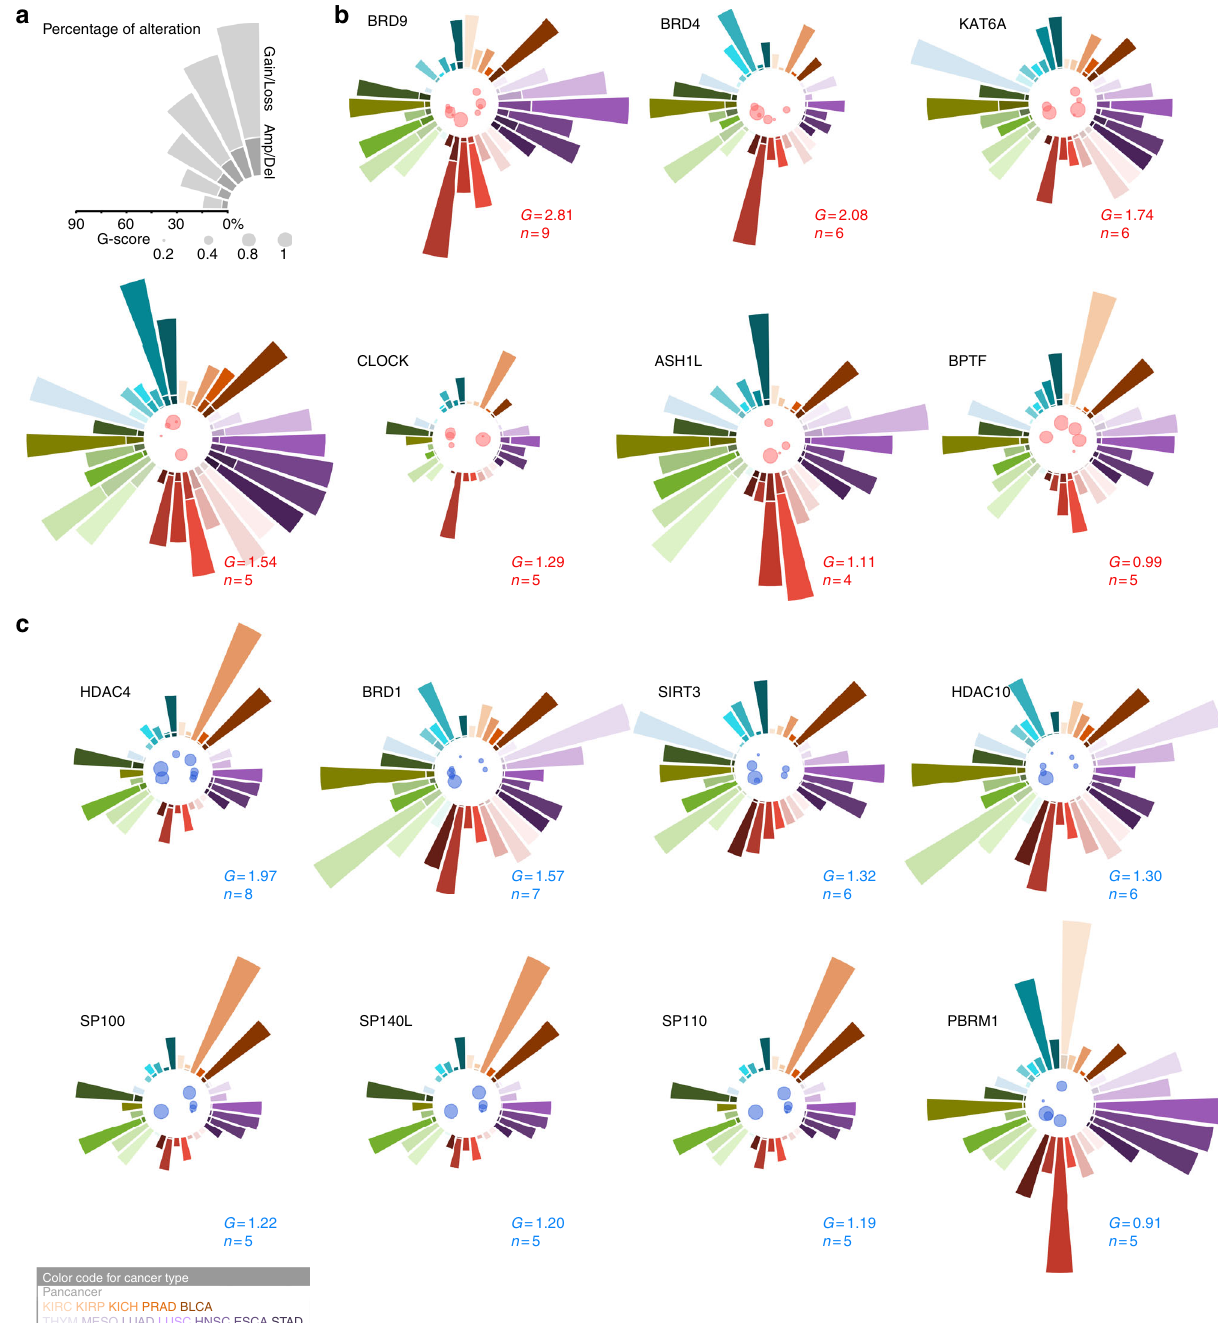
Fig. 3 The putative cancer-causing HAMPs driven by SCNAs across cancers. a The scales of the alteration percentage (upper) and G-score (lower). b , c Seven and eight putative cancer-causing HAMPs that are commonly and recurrently gained ( b ) or lost ( c ), respectively, across 33 cancers (overall G-score > 0.9). In the center of each circle, the cancer types that harbored recurrent alterations of a given HAMP are indicated by a color-coded bubble (red: gain; blue: loss). The size of the bubble plot represents the G-score of the HAMP in a given cancer type. The bar diagram of each circle shows the percentage of gain/ampli fi cation ( b ) or loss/deletion ( c ) of certain HAMPs in individual cancer types. The cancer type is coded by color. Gain: GISTIC status = 1; ampli fi cation: GISTIC status = 2; loss: GISTIC status = − 1; and deletion: GISTIC status = − 2. The overall G-score and the number of cancer types that harbored recurrent alterations are indicated as G and n ,